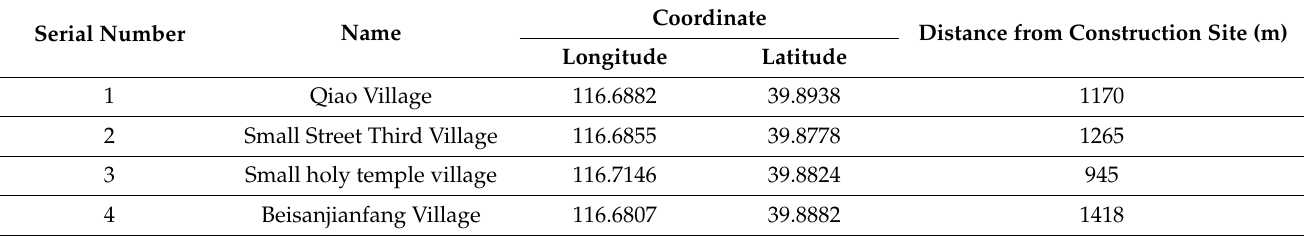
Table 3. Four residential area target location